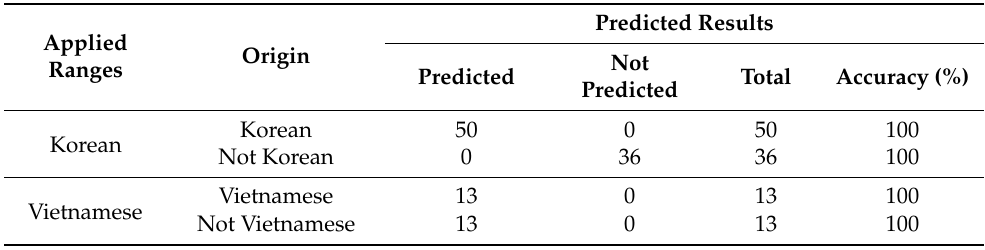
Table 6. Reclassification results for red pepper powder samples using the ranges of the indicator variables.